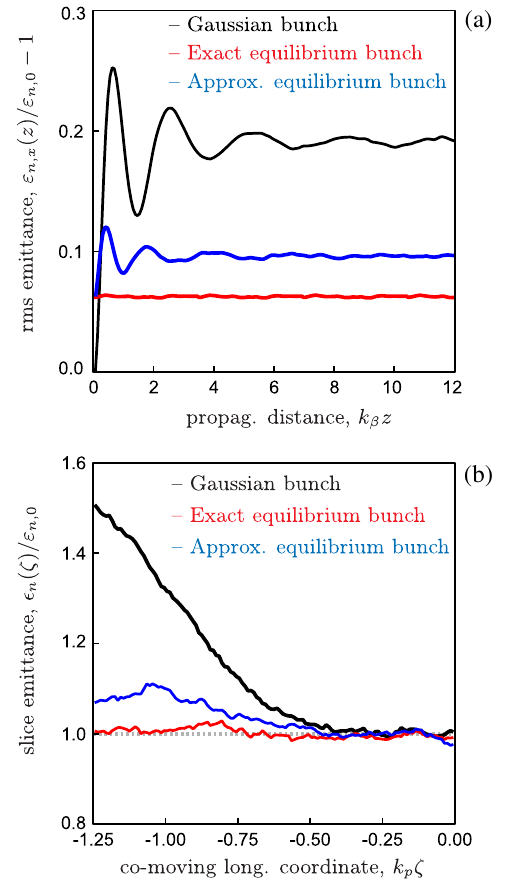
FIG. 2. (a) Emittance evolution for: Gaussian bunch initially matched in the unperturbed wakefield [black]; matched equilib- rium bunch obtained solving Eqs. (23), (28) [red]; approximate equilibrium bunch where the transverse profile is Gaussian but with the same rms properties of the exact equilibrium [blue]. (b) Slice emittance measured for k β z ¼ 12 (saturation) for the three types of bunches in (a). The bunch parameters are 10 10 , L ≃ 20 μ m (flat longitudinal current profile), N b ¼ b γ n 0 ¼ 10 17 cm − 3 drogen ion density is n i; 0 ¼